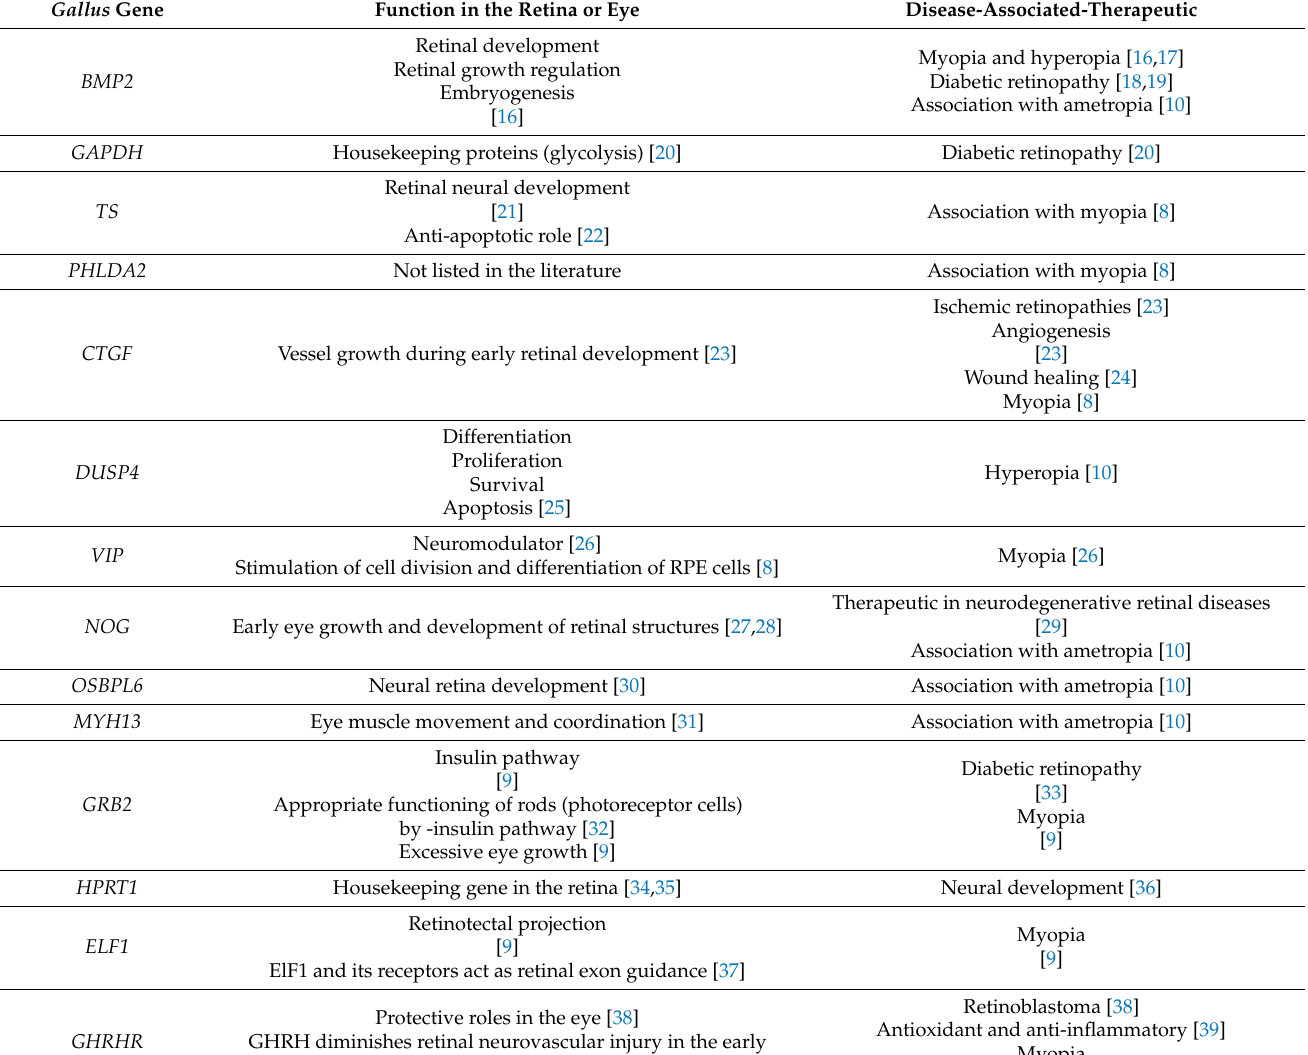
Table 3. List of the known function of the 14 retinal genes used in this study and their association with diseases or potential use in therapy (based on literature